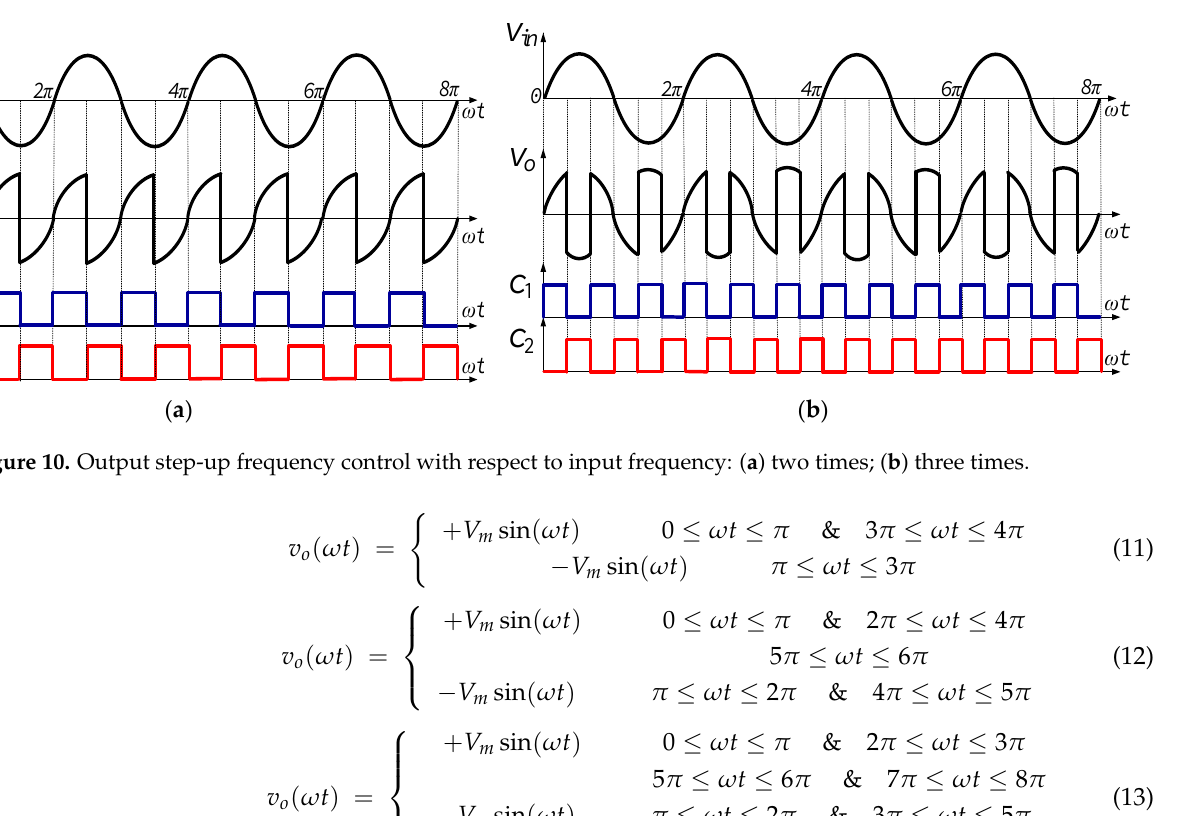
voltage. While in the case of tree time output frequency, the voltage at the output is non- inverted and inverted two and one-time respectively in each half cycle of the input volt- age.